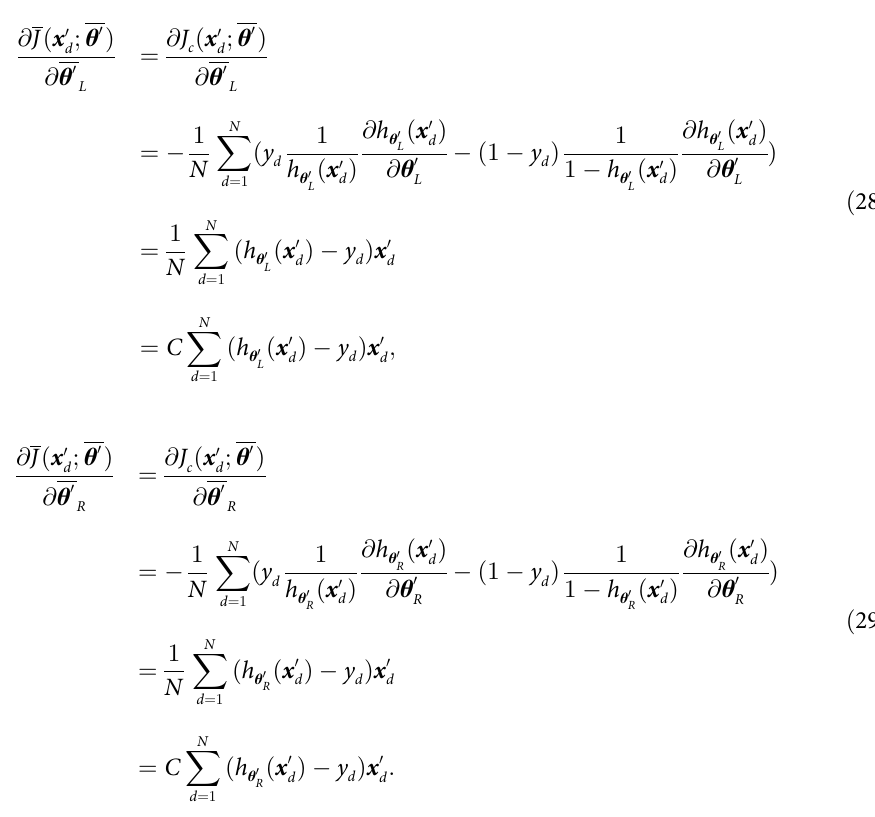
Algorithm 3 The learning algorithm of